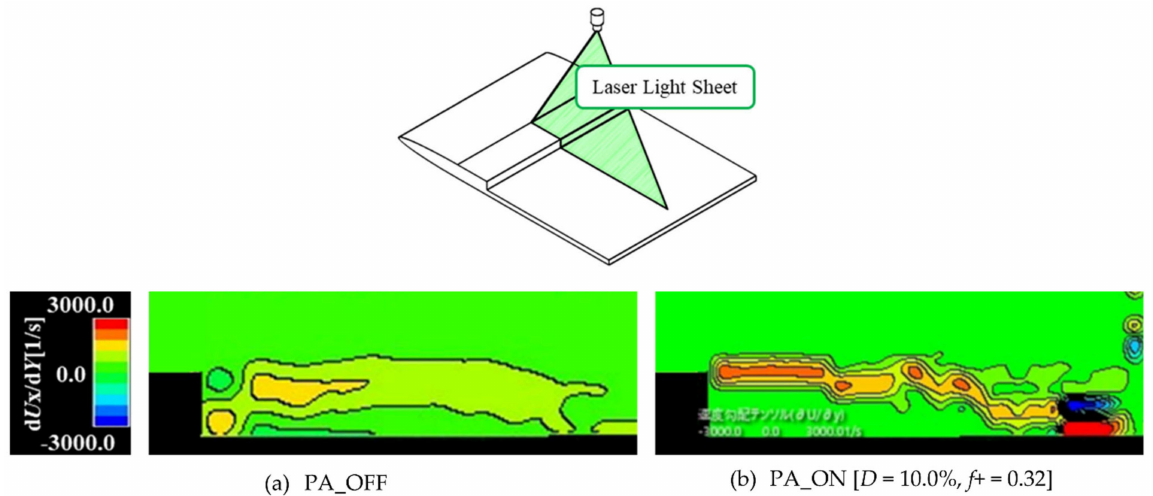
Figure 14. Iso-d U x/d Y